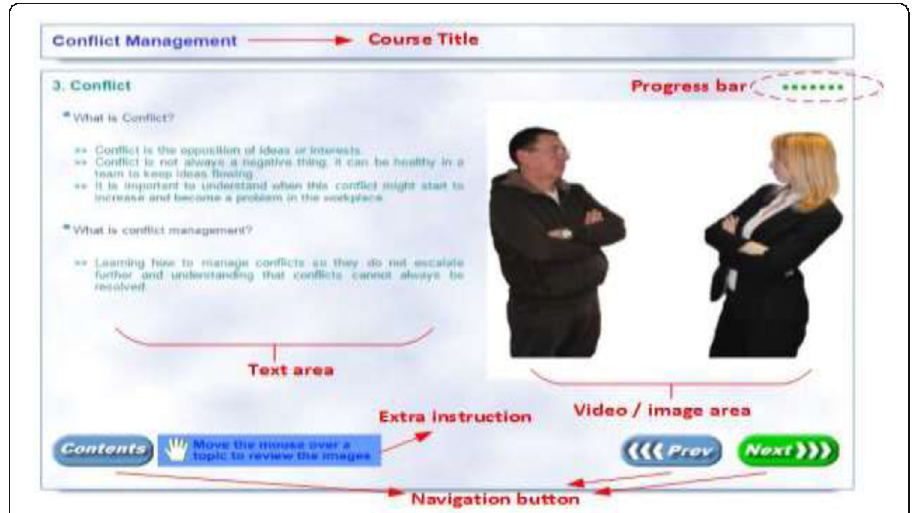
Fig. 1 Example of page template on Conflict